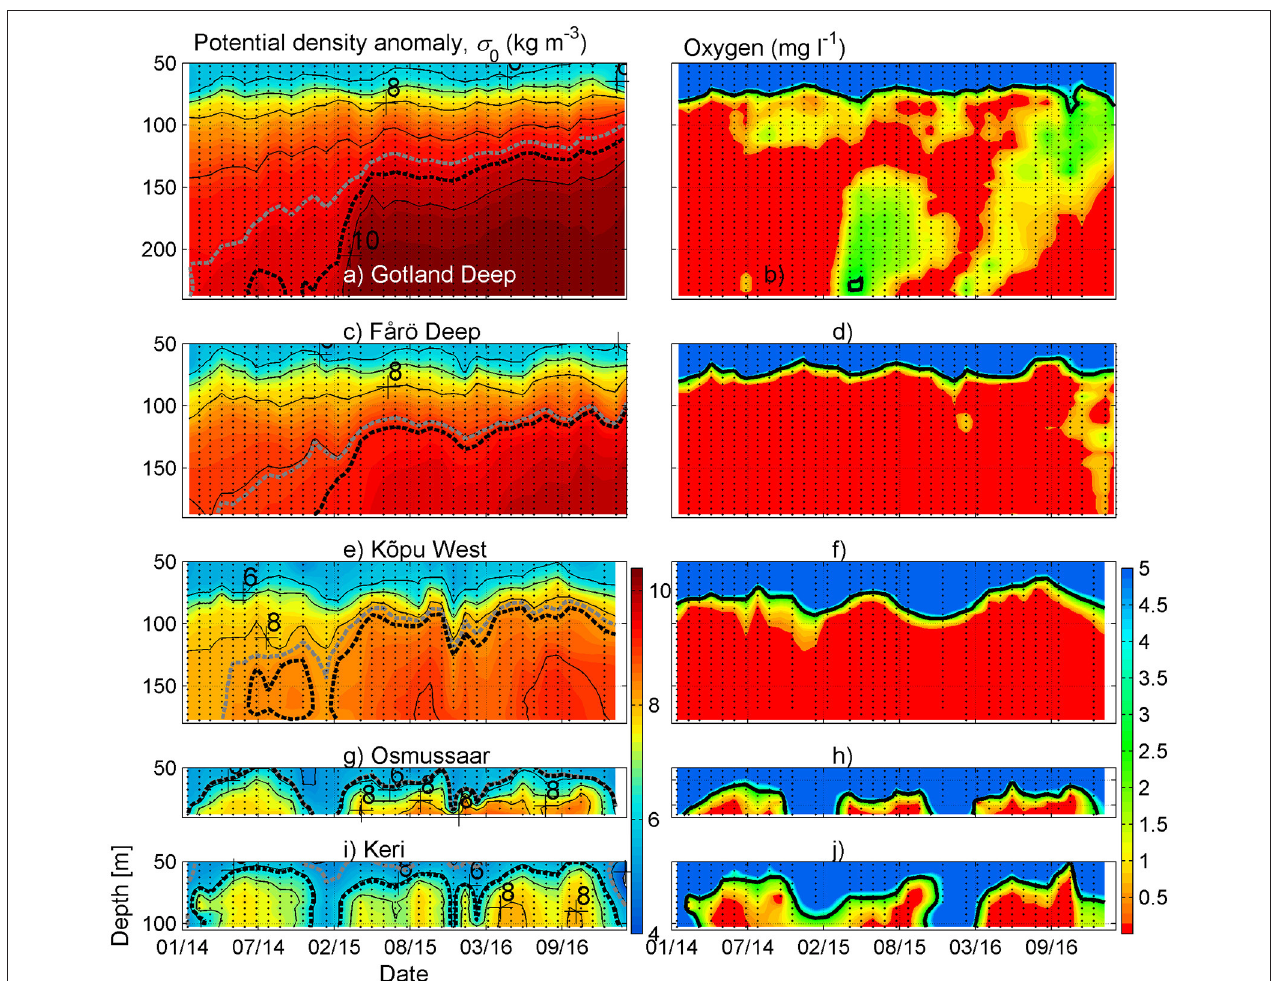
FIGURE 5 | Time-series of monthly mean density and oxygen in the Gotland Deep (a, b) , Fårö Deep (c, d) , Kõpu West (e, f) , Osmussaar (g, h) and Keri area (i, j) from January 2014 to March 2017. Black dashed lines (left panels) show the near-bottom water density before the water of MBI in December 2014 arrived to the Gotland Deep. Gray dashed lines show density in the beginning of our study period (February 2014). Black solid isolines are shown on density plots by 1kg m − 3 step. A black bold line (right panels) marks the dissolved oxygen concentration of 2.9mg l − 1 (threshold concentration for hypoxia). Vertical dashed lines represent the months with available